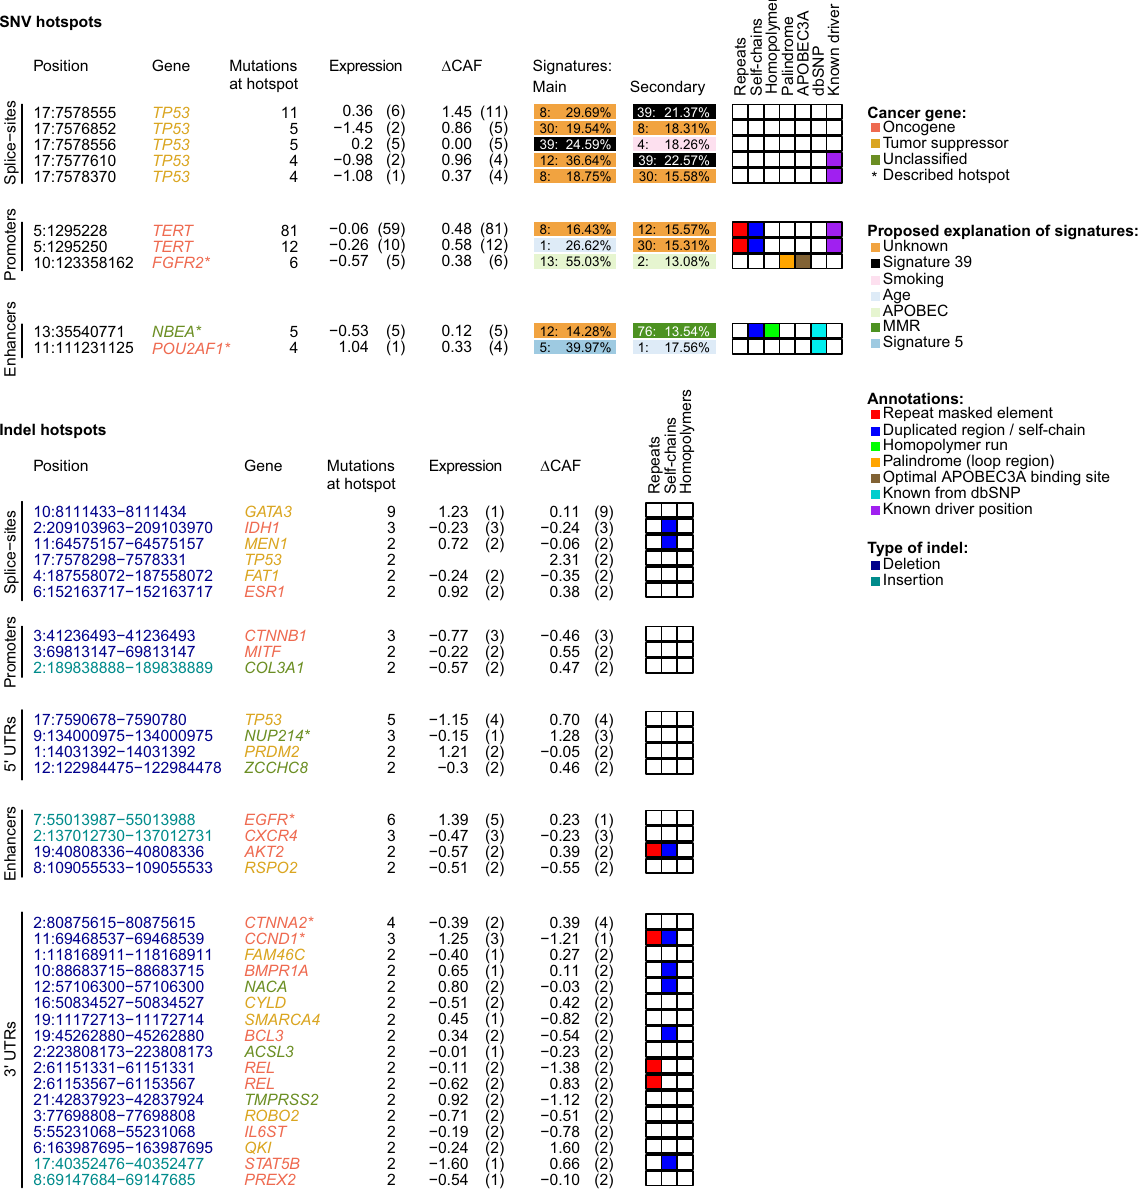
Fig. 4 Description of gene-regulatory hotspots related to cancer genes. Annotation of position, gene, number of mutations at a hotspot, expression z -score, Δ CAF z -score and three (indels)/six (SNVs) genomic features; for SNVs the annotations further include the top-2 signatures; includes all gene-regulatory indels with two or more mutations and SNVs with four or more mutations associated with cancer genes; positions are given according to the hg19 reference genome. MMR: mismatch repair. tumor suppressors (shift = 0.28; q = 1.77 × 10 − 6 ; Fig. 5; Supple- affected by this mechanism, so they do not necessarily affect the mRNA level. We expect mainly missense mutations in oncogenes, mentary Table 2; “ Methods ” section). These expression aberrations as speci fi c amino acid changes are typically needed to activate could potentially be caused by selection, by some tumor these genes 6 – 8 . Even though the missense mutations in onco- suppressors being bivalent with oncogenic properties, or by feedback mechanisms, where the aberrant protein function leads genes may not directly lead to increased expression levels, we to increased gene expression levels. If the latter is the case, we expect increased expression levels in oncogenes potentially would expect a similar rise in expression levels among patients caused by epigenetics or the selection of regulatory mutations. with singleton missense mutations. We do see a similar pattern for Across highly mutated protein-coding SNV hotspots, we the missense singletons both for tumor suppressors in general observed expression aberrations for hotspots with missense and for the subset of tumor suppressors harboring hotspots mutations in oncogenes (shift = 0.25; q = 1.77 × 10 − 6 ) and hot- (shifts = 0.21; Fig. 5). Neither missense (shift = 0.10; q = 0.300) spots with nonsense mutations in tumor suppressors (shift = − 0.51; q = 3.59 × 10 − 4 ) when compared to wild-type expression in nor nonsense mutations in non-cancer genes (shift = − 0.014; q = 0.626) were associated with signi fi cant aberrations. For the the same genes, as expected. Interestingly, we also observed protein-coding indel hotspots, only frameshift indels in tumor expression aberrations for hotspots with missense mutations in npj Genomic Medicine (2021)